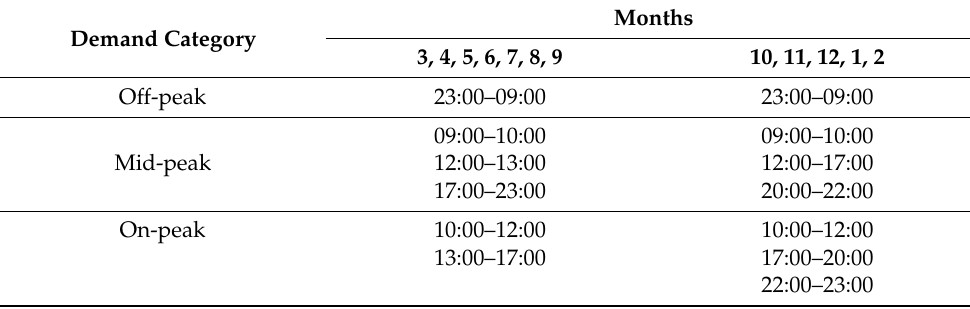
Table 7. Peak times classified by hour and month.